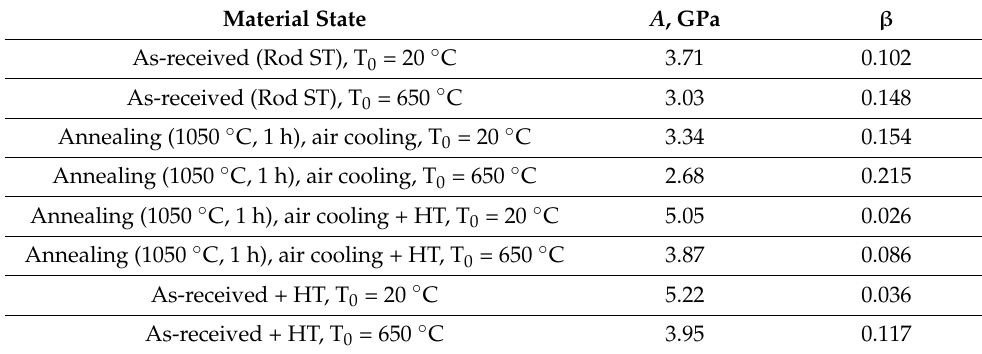
Table 5. Coefficient A and power exponent β of the approximating function